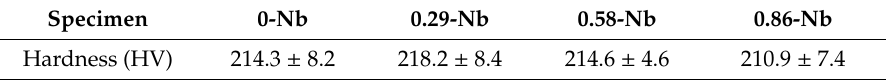
Figure 1. Optical micrograph of 22Cr25NiWCoCu stainless steels with Nb contents of ( a ) 0, ( b ) 0.29, ( c ) 0.58, and ( d ) 0.86 wt.%. Table 2. Vickers hardness of 22Cr25NiWCoCu stainless steels with 0–0.86 wt.% Nb.